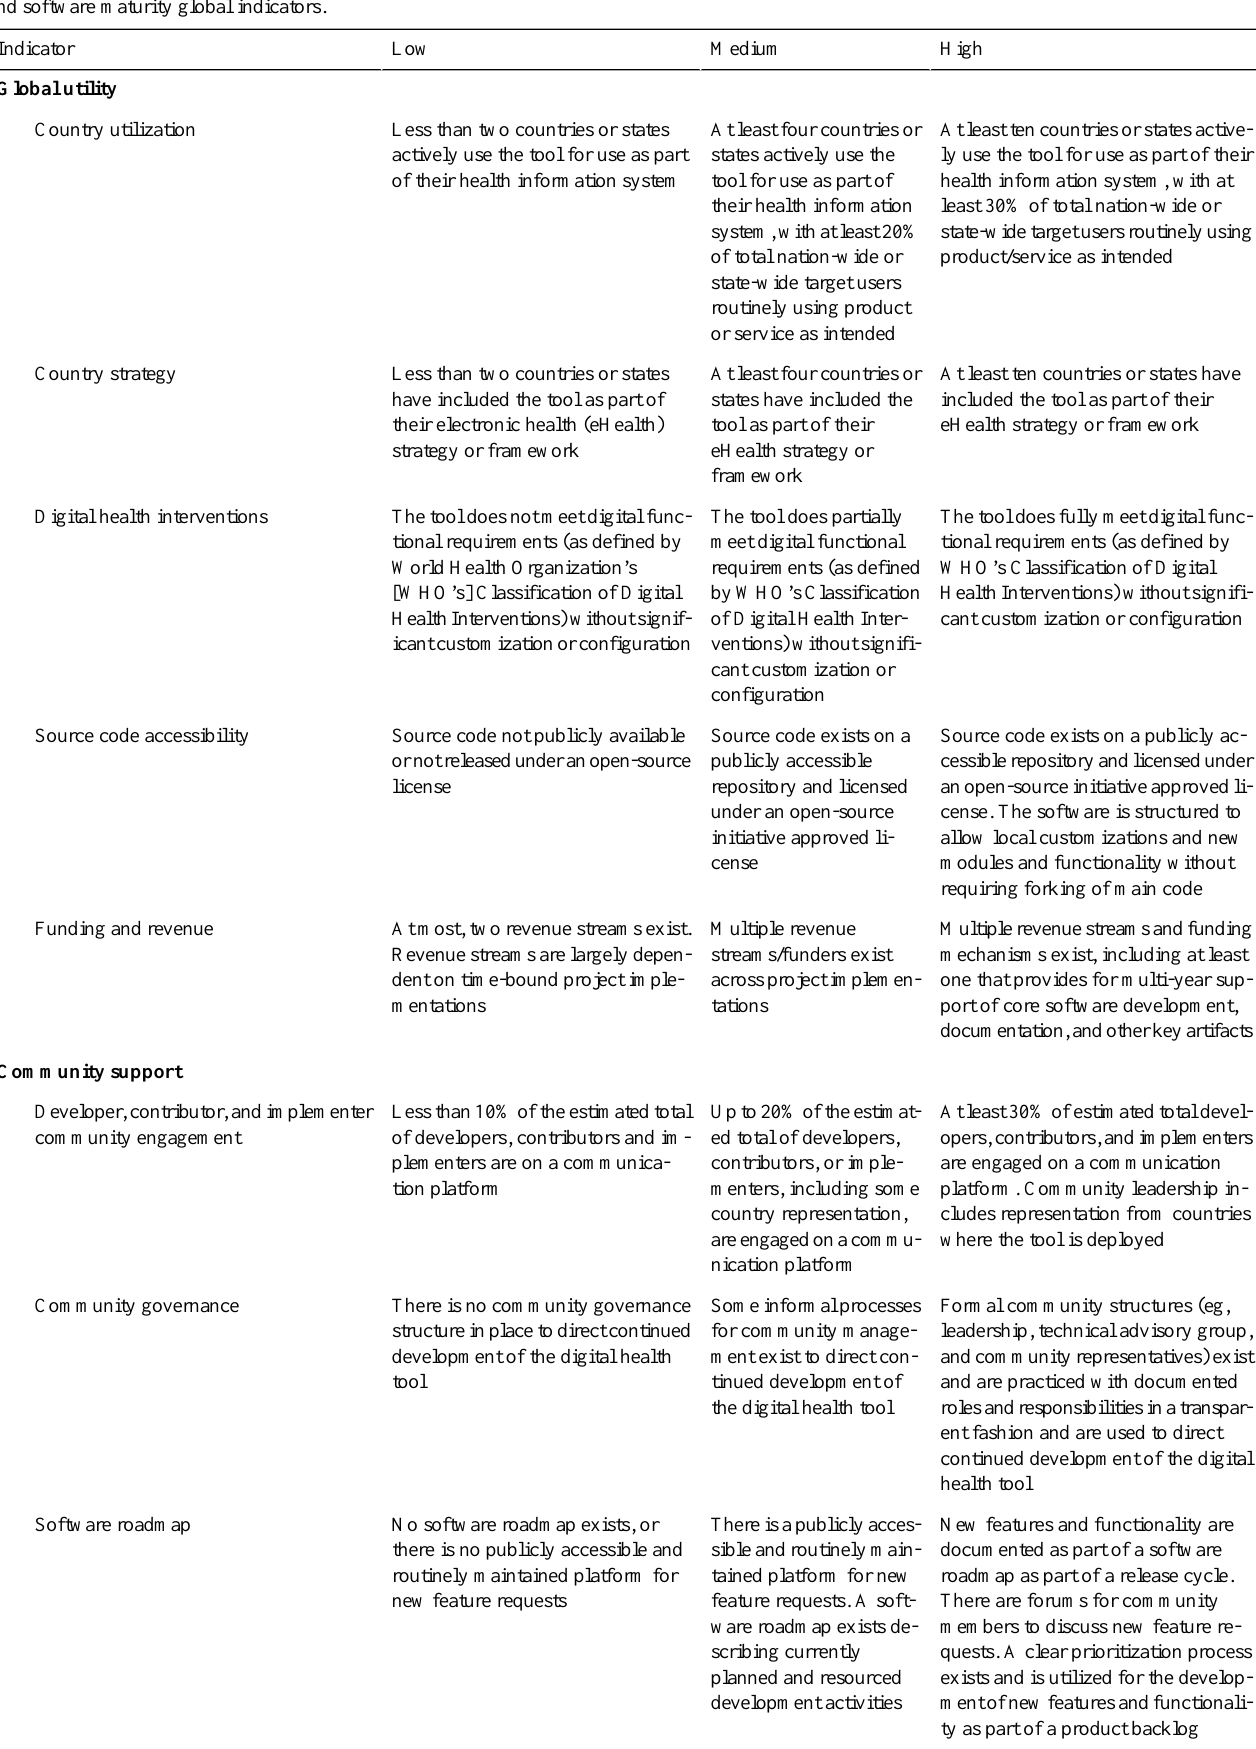
Table 1. Global good maturity model 1.0 guideline of digital intervention tools containing 15 subindicators from global utility, community support, and software maturity global